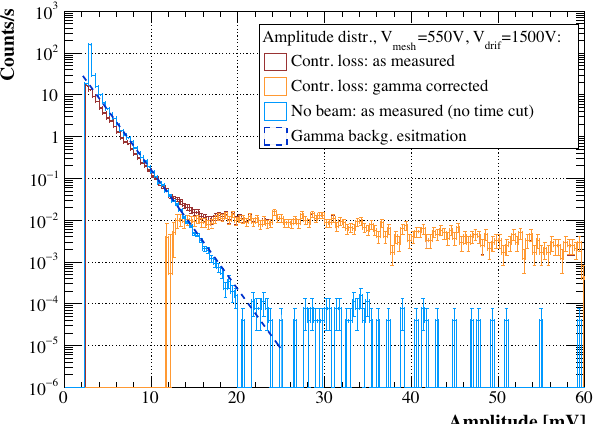
FIG. 15. Distribution of IE t over event start time inside TOT machine cycle for data collected during the controlled loss experiment.